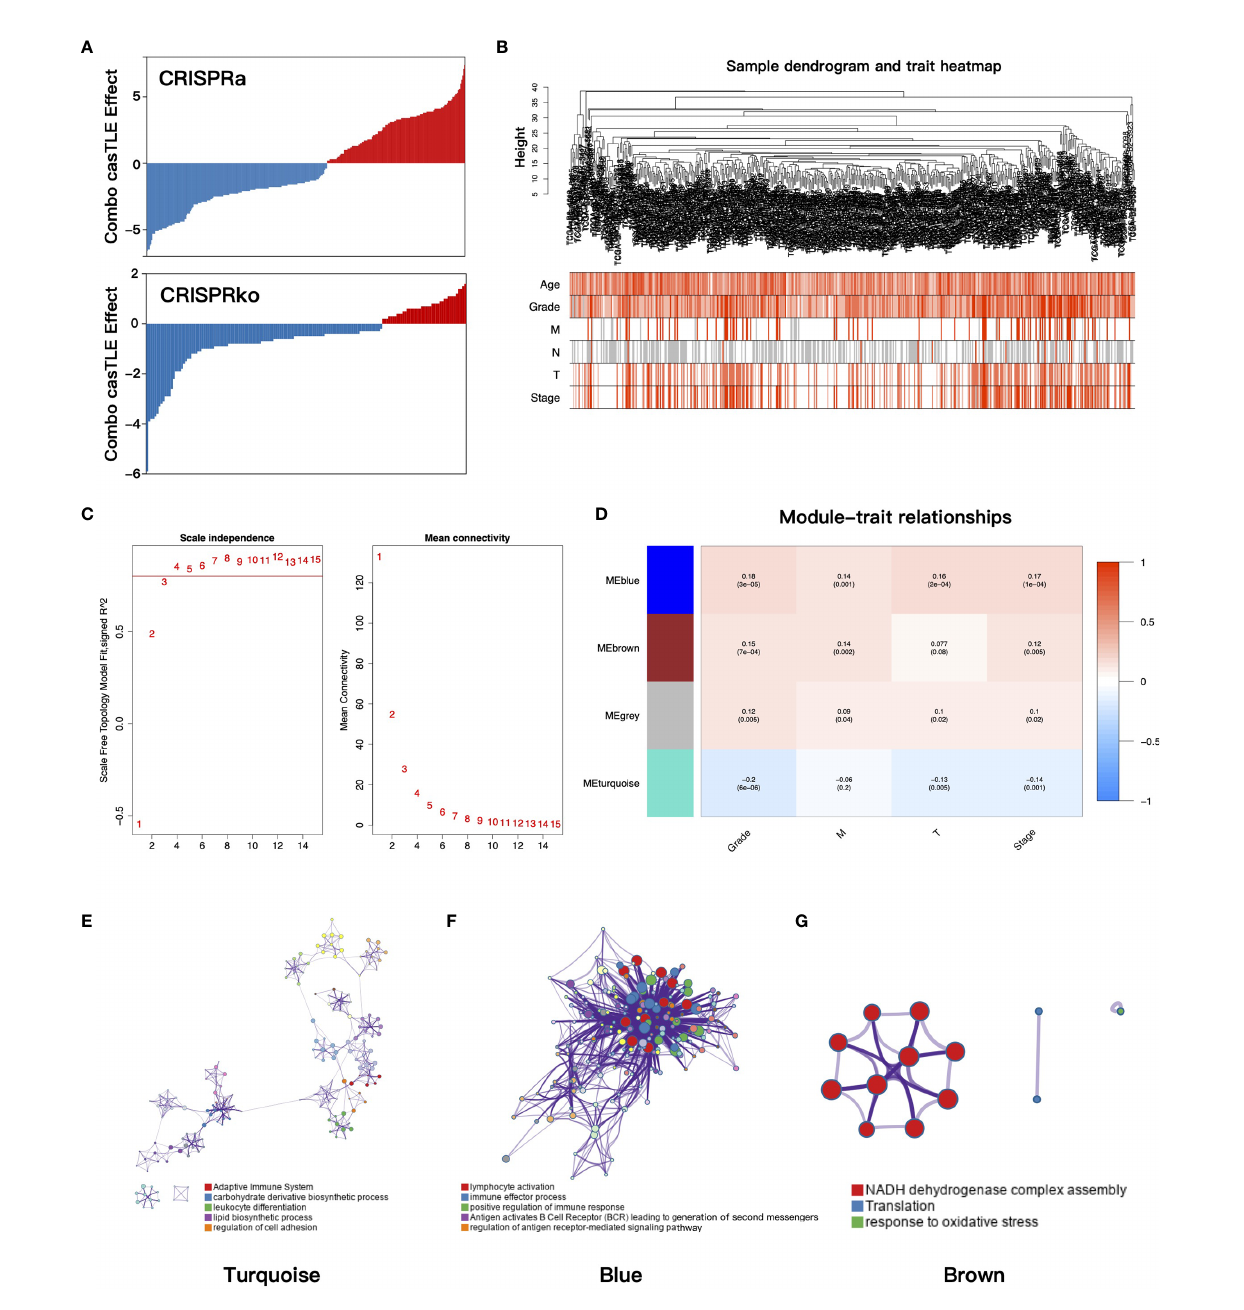
FIGURE 1 | (A) The casTLE score of ADCP-related genes in the CRISPR/Cas9 screen. (B) Clustering dendrogram and clinical traits heatmap of ccRCC patients based on ADCP-related genes. The shade of color in the heatmap increased with age, Fuhrman grade, pathology T stage, and pathology stage. Red, white, and gray are on behalf of metastasis, no metastasis, and data missing in pathology M and N stage, respectively. (C) The relationship between the soft threshold and the index of scale-free topologies and mean connectivity. (D) The heatmap of the correlation of gene modules and clinical traits. In each grid, the top number was the coef fi cient between gene modules and clinical traits, and the bottom was the p-value. (E – G) The functional clustering network of turquoise, blue, and brown modules. casTLE, cas9 high-throughput maximum likelihood estimator; ADCP, antibody-dependent cellular phagocytosis; ccRCC, clear cell renal cell